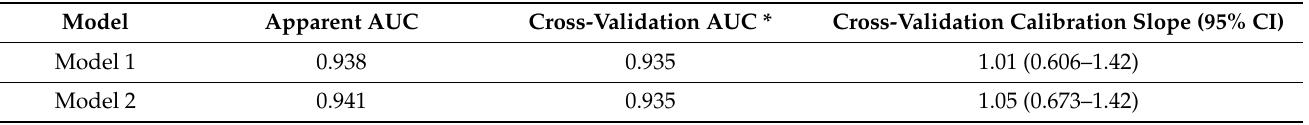
Table 3. Model discrimination and calibration.